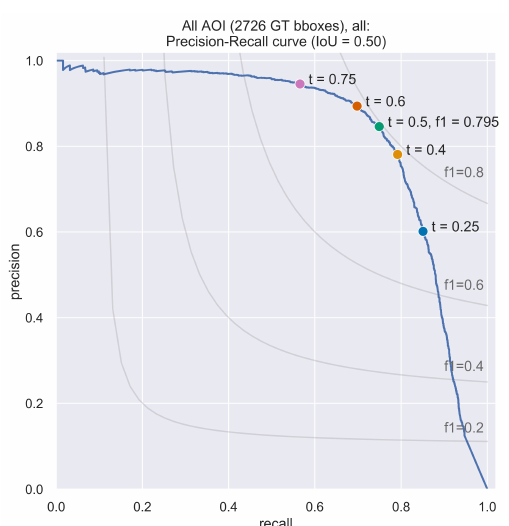
Figure 2. RetinaNet precision-recall curve on the test set of the WV dataset. The colored circles depict possible thresholds t on the prediction score. Isolines for F1-score are drawn in